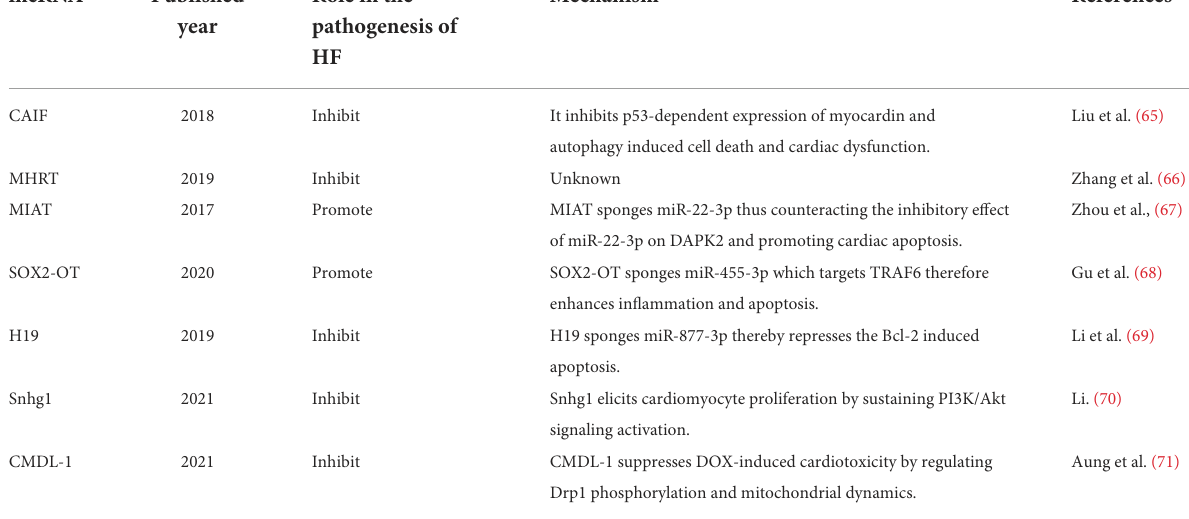
TABLE 3 lncRNAs involving in cardiac